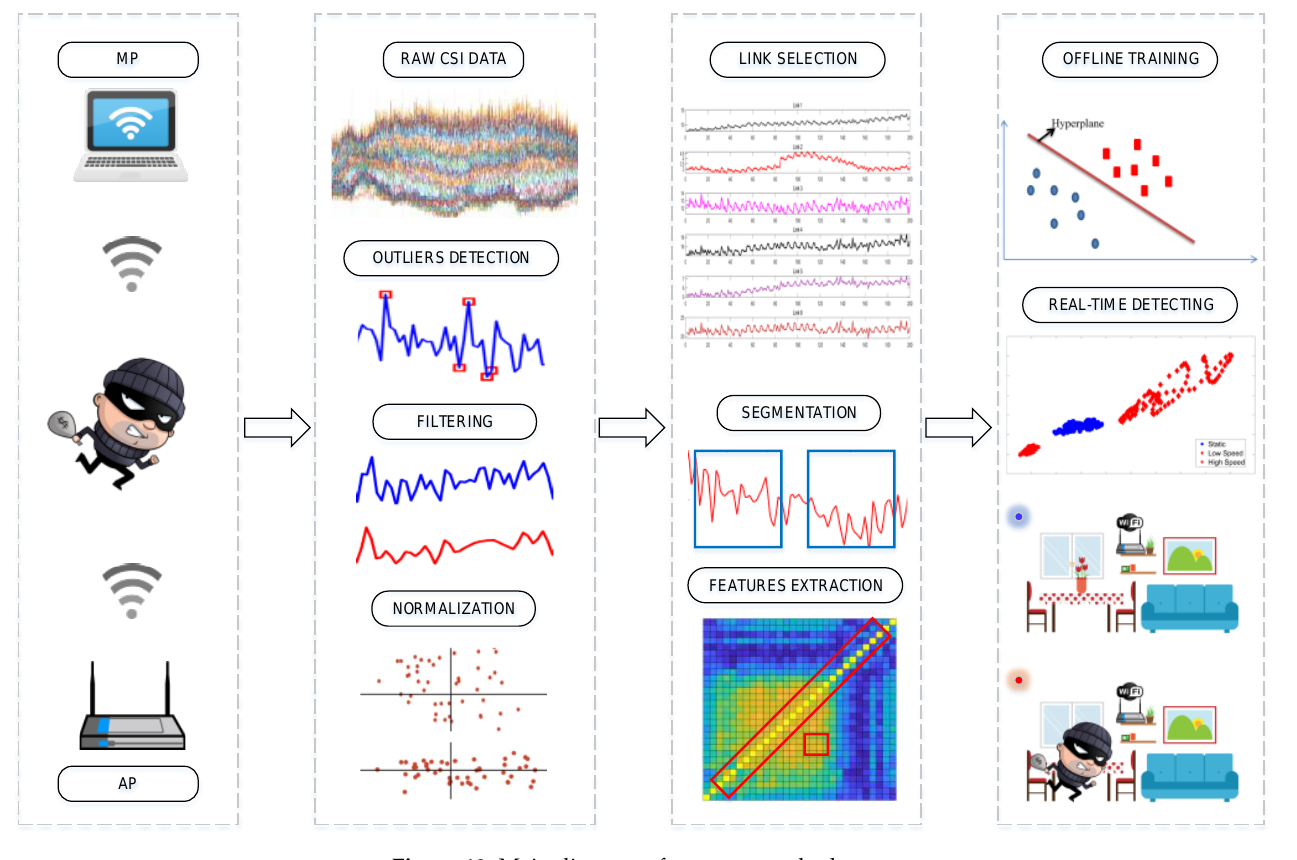
Figure 10. Main diagram of our proposed scheme. Table 1. Channel state information (CSI) data field